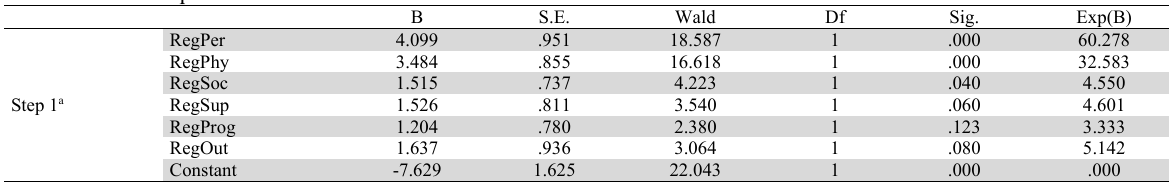
Variables in the Equation